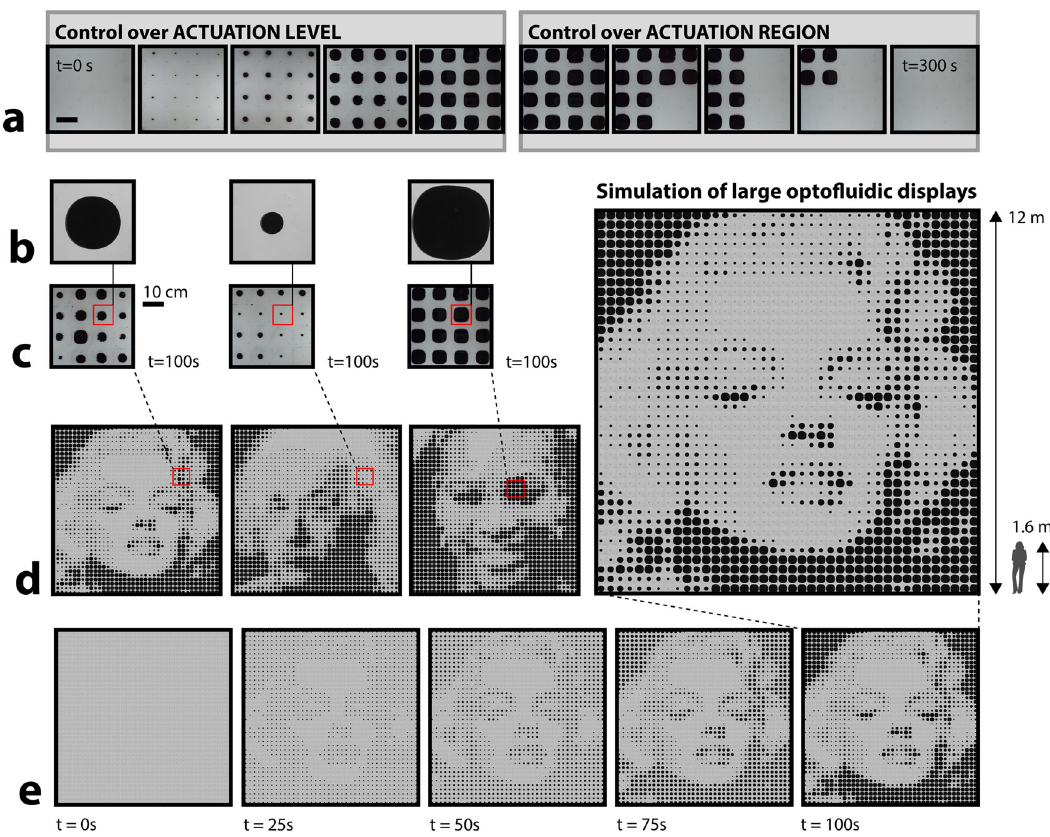
Fig. 5 Envisioned large-area pigment con fi gurations to display halftone imagery. a Demonstrated control over pigment fl uid actuation level and region. Scale bar is 10 cm. b – d Pattern control at three scales over time. b – c are physically demonstrated; d is simulated. e Pattern de fi nition clarity improves over time, as pigment fl uid is dispersed differentially. Original images are from 85 – 88 . Images of Marylin Monroe and Serena Williams were both licensed as an Image for Artistic Reference from